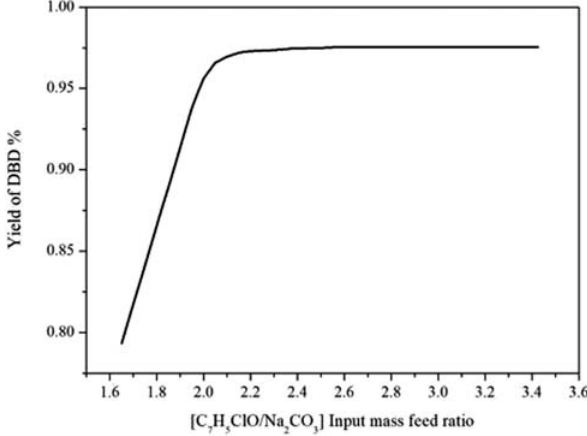
Figure 9: Relationship between the feed ratio of C 7 H 5 ClO/Na 2 CO 3 and the DBD